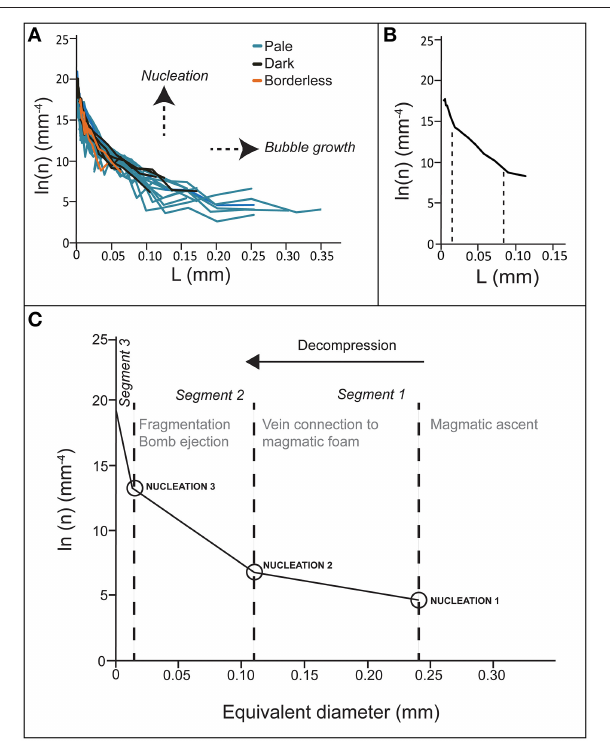
FIGURE 7 | (A) Vesicle size distributions expressed as number n of vesicles within specific size bins present per mm 3 . Orange curves correspond to borderless clasts, which contain the smallest vesicle population. Black curves represent dark clasts, which contain the two smaller bubble populations, and blue curves correspond to pale clasts. Appearance of smooth pattern is caused by superposition of several-slope curves instead of real smooth curves. (B) A typical example of three-slope VSD pattern, from a dark clast. (C) Model of vesicle population evolution. Final precision on coordinates is ln(n) and 0.01mm in equivalent diameter. Each curve segment represents a ± single bubble nucleation